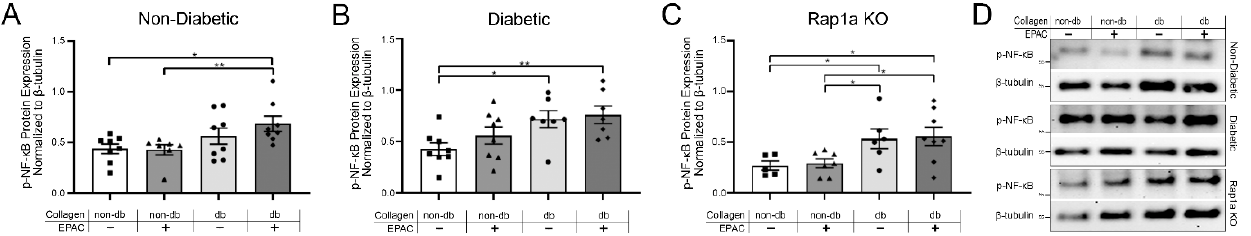
Figure 5. Endogenous AGE exposure and increased Rap1a activity caused elevated p-NF- κ B protein expression. ( A ) Non-diabetic, ( B ) diabetic, and ( C ) Rap1a KO cardiac fibroblasts (P1) were cultured on either non-diabetic or diabetic collagen. Fibroblasts were either left untreated or treated with EPAC (100 µM) and total protein was isolated. p-NF- κ B (65 kDa) protein expression was assessed and normalized to β -tubulin (55 kDa) protein expression. Data presented in graphs are mean ± SEM ( n = 6–9). Significant differences were determined using one-way ANOVA followed by a Fisher’s Protected Least Significant Difference post hoc (* p < 0.05 and ** p < 0.01). ( D ) Representative Western